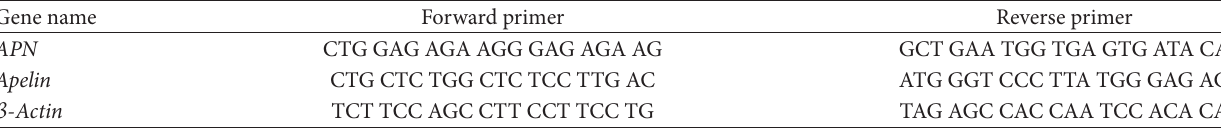
Table 1: The primer sequences of the APN, apelin, and 𝛽 -actin.